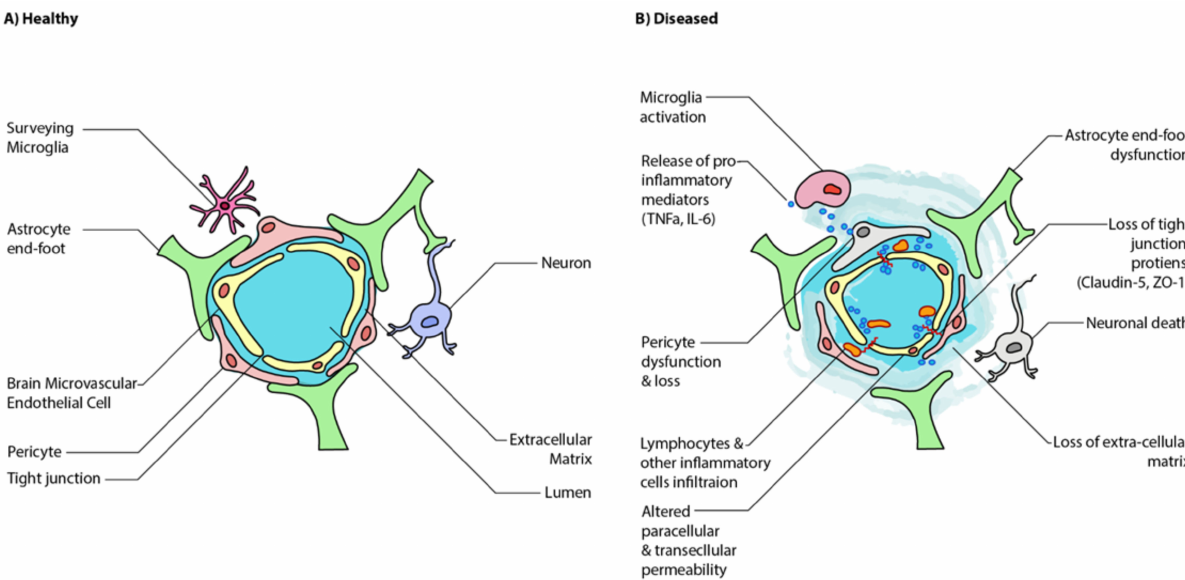
Figure 2. Schematic illustration of healthy and disease state blood-brain barrier (BBB) epithelium. ( A ) A healthy BBB is tightly sealed by the tight junctions of endothelial cells and astrocytes. ( B ) A disease state BBB has increased translocation of inflammatory mediators, immune cells, and microglial activation, which further increases BBB permeability. Ultimately, this results in neuroinflammation and neuronal cell death. Adapted from